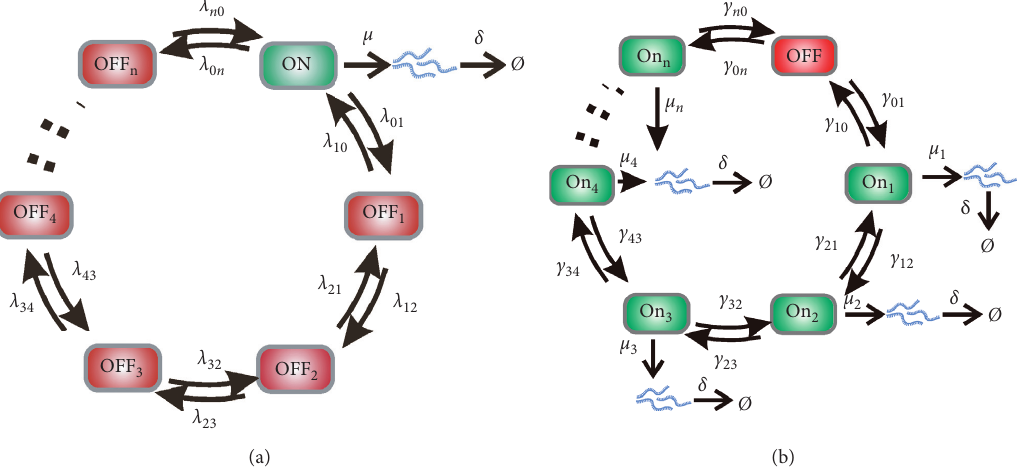
Figure 3: (a) Schematic diagram for a gene model with the promoter having one ON and multiple OFFs. These chromatin states form a loop and transition from one state to its neighboring state with a constant transition rate. (b) Schematic diagram for a gene model with the promoter having one OFF and multiple ONs. These promoter states also form a loop and transition from one state to another state with a constant transition